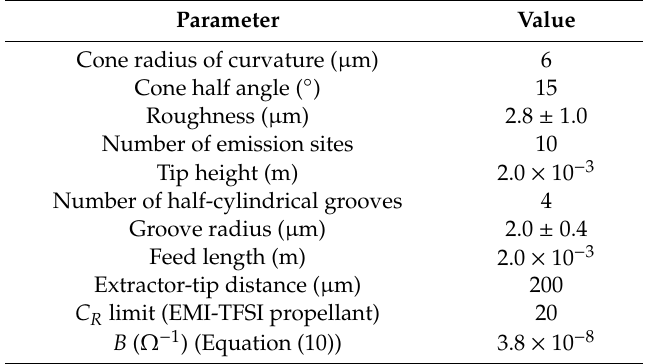
Table 10. List of input parameters for externally wetted tungsten emitter